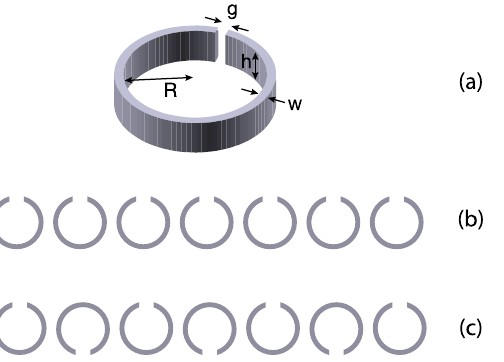
Figure 6. Schematic for ( a ) a single SRR element with inner radius R , width w , height h , and gap g , ( b ) a linear ‘uu’ array, which has positive nearest-neighbour coupling coefficient and ( c ) a ‘un’ array which has negative nearest-neighbour coupling coefficient.